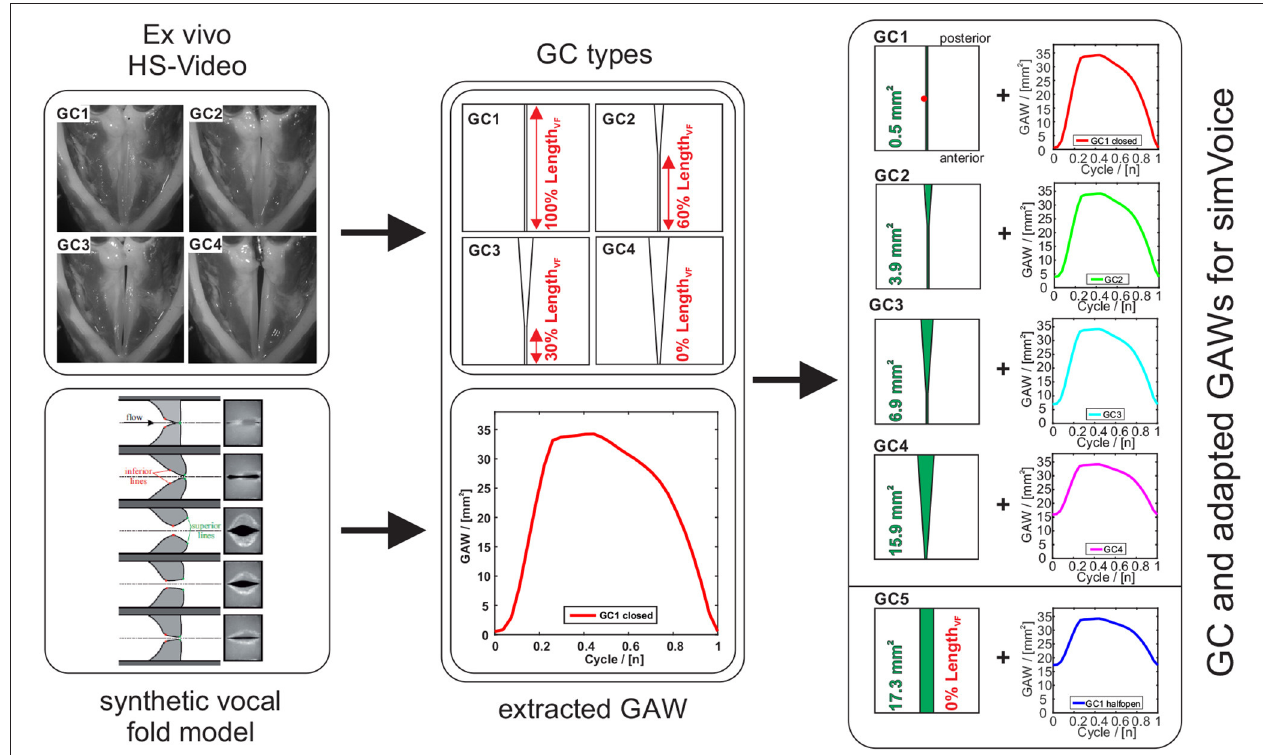
FIGURE 3 | Workflow of vocal folds modeling. Upper left part: four GC types of ex vivo experiments based on high-speed videos (Birk et al., 2017b) and the corresponding schematic numeric GC geometries (superior view). Lower left part: phases of the vocal fold motion of the synthetic vocal fold model (view on the coronal plane) during one oscillation cycle (Lodermeyer et al., 2015) and the GAW was taken from high-speed videos (Sadeghi et al., 2018). Right part: Four plus one additional GC types with the adapted